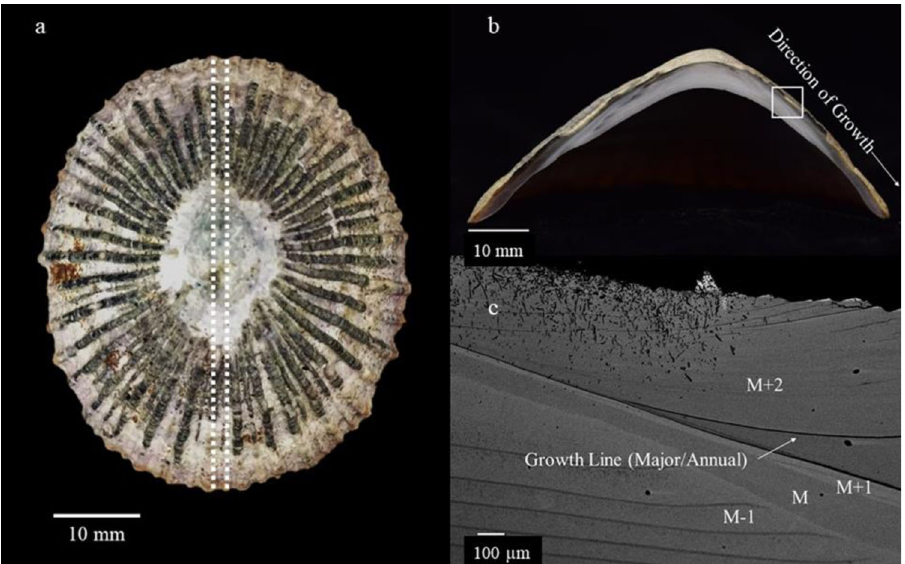
Fig. 1 Shell specimen and microstructures. Shells were sectioned from anterior to posterior end. a White lines represent parallel cuts for thick-section preparation from historical specimen BPBM 250851-200492. b Cross-sections show the true direction of growth for limpets. c SEM exposed shell microstructures for area denoted in b . Oxygen isotope measurements were performed along the direction of growth in the crossed-foliated, calcite layer M +